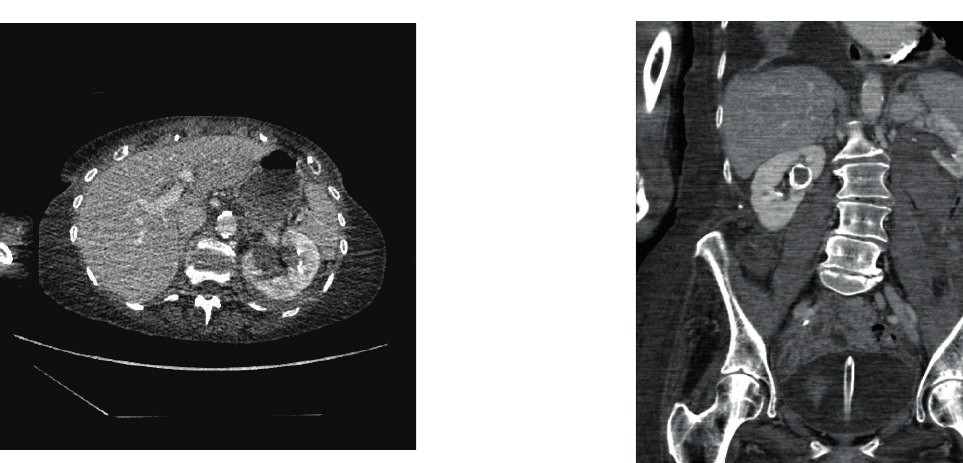
Figure 3: Split bolus contrast CT KUB: coronal section, left kidney with hydronephrosis and right kidney calcification.